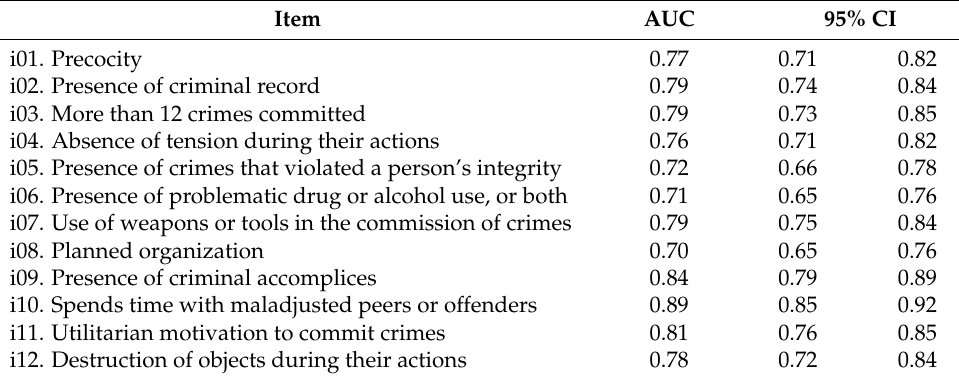
Table 7. Indices of area under the curve and confidence interval for the EGED. Item